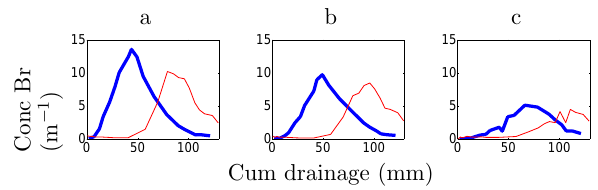
Fig. 9. Breakthrough curves of bromide for the snowmelt experiment (thick blue line) and the irrigation exper- iment (thin red line), for fast cells (a) , average cells (b) , and slow cells (c) .